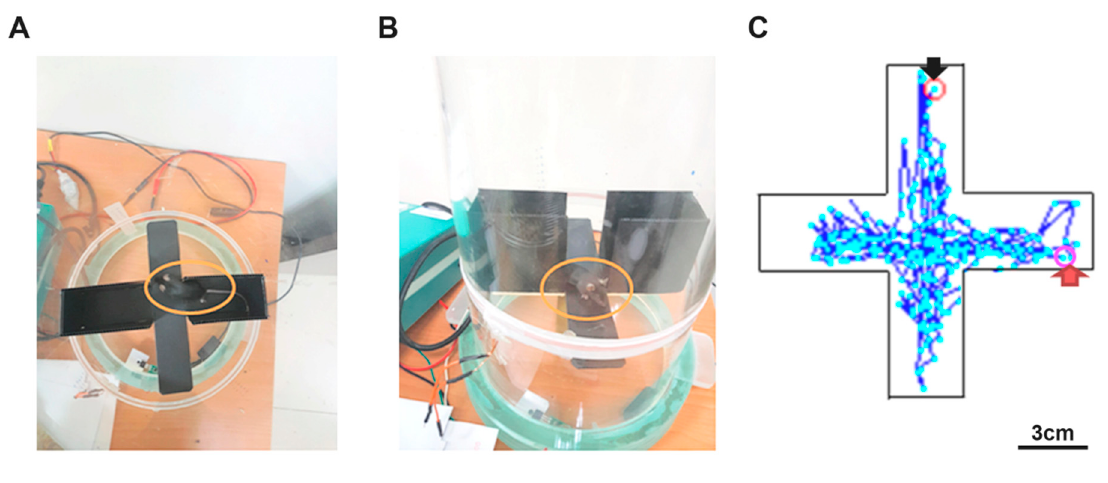
Figure 7. Anxiety behavior test in the elevated plus maze task with optogenetic photostimulation. ( A , B ) These pictures depict testing anxiety behavior of the elevated plus maze task; the optical fiber was implanted into the medial prefrontal cortex (mPFC). ( C ) Using the auto-tracking device, the animals’ path was drawn with photostimulations into the mPFC in the elevated plus maze task. The black arrow represents the starting point and the red arrow represents the ending point.